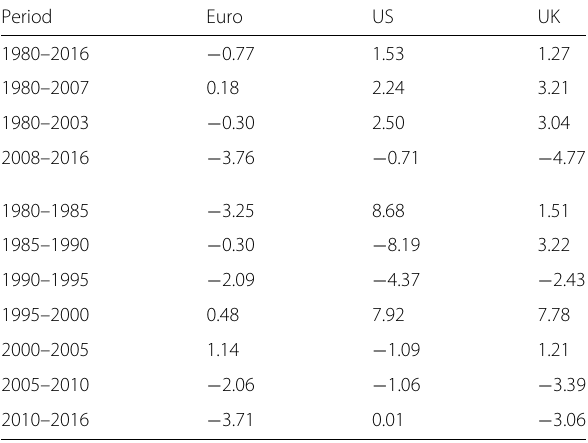
Table 6 Average yearly teturn differences—unhedged minus hedged